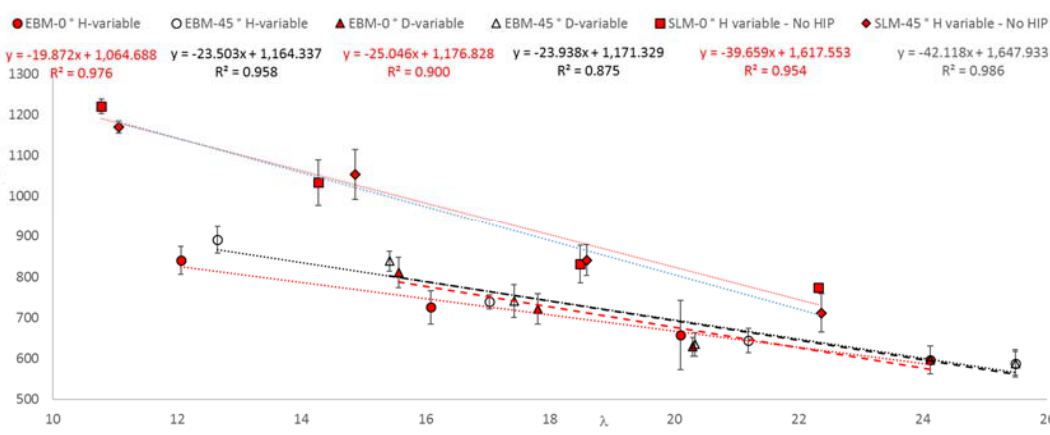
Figure 19. Correlation between compressive strength and slenderness ratio of EBM-manufactured parts. Results are shown as mean values with the corresponding standard deviations. For the linear regressions, the coefficient of determination is shown.